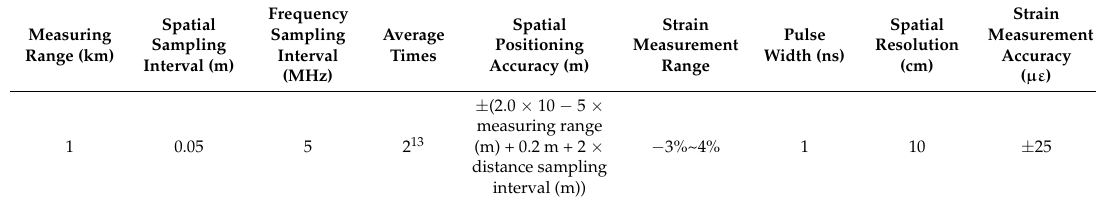
Table 3. Main technical performance indicators of NBX-6000 in test model monitoring.